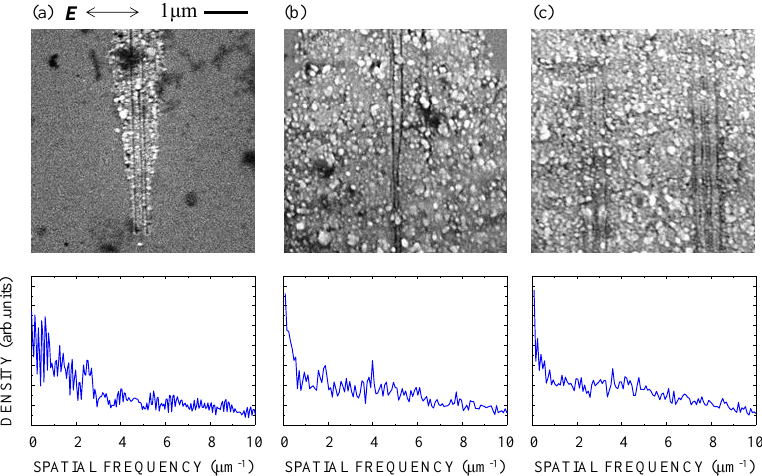
Figure 4. SEM image (top) and Fourier spectrum (bottom) of the silicon suboxide films irradiated with ( a ) N = 250, ( b ) N = 500, and ( c ) N = 1000 fs laser pulses at F = 675 mJ/cm 2 . E denotes the direction of the polarization.